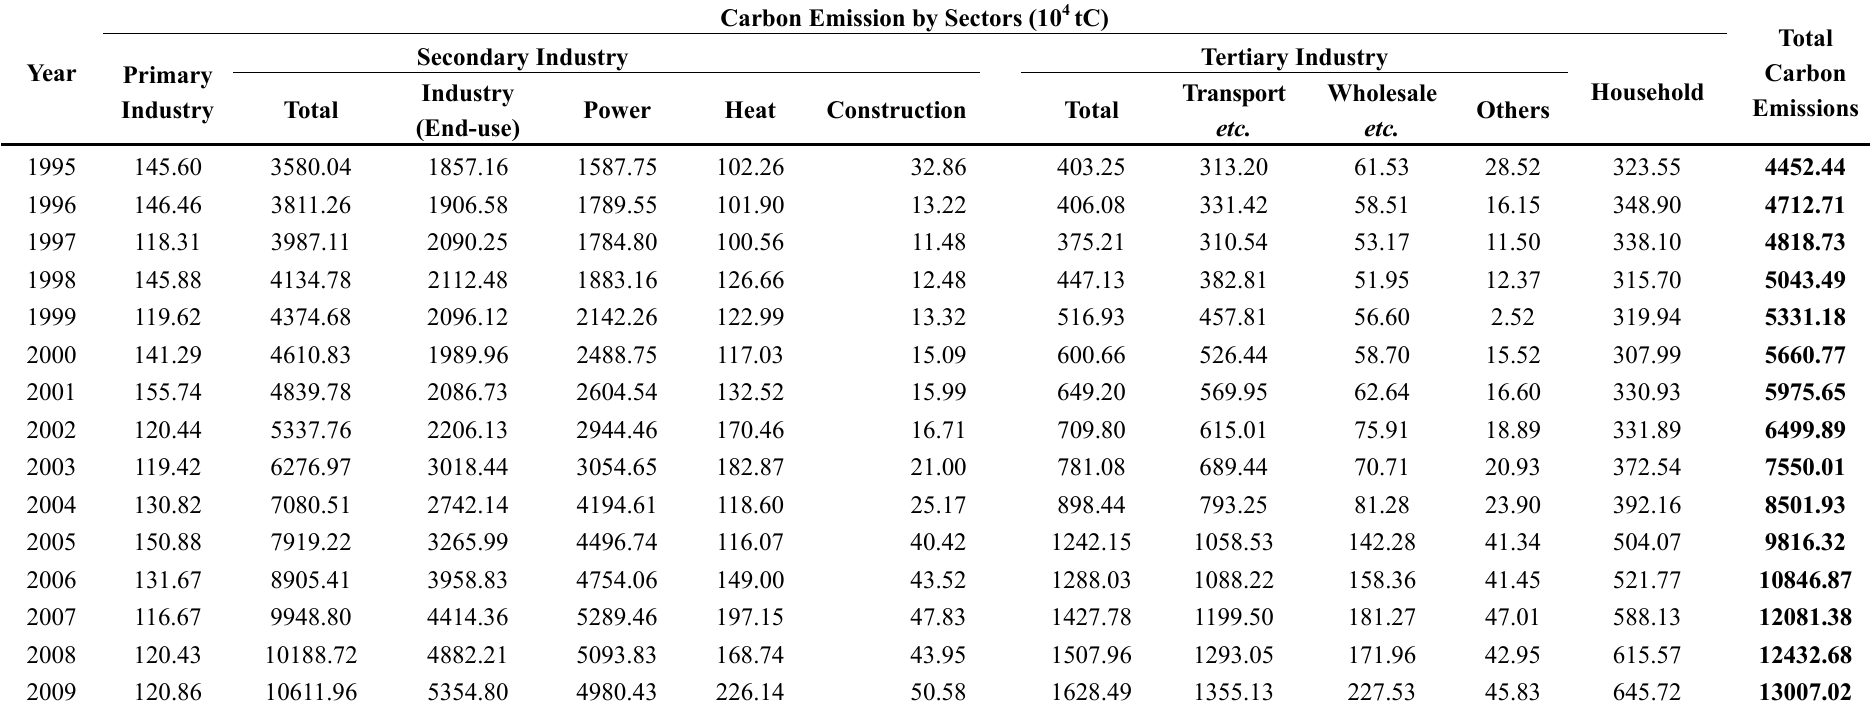
Table 2. Estimation results of energy-related carbon emissions in Guangdong